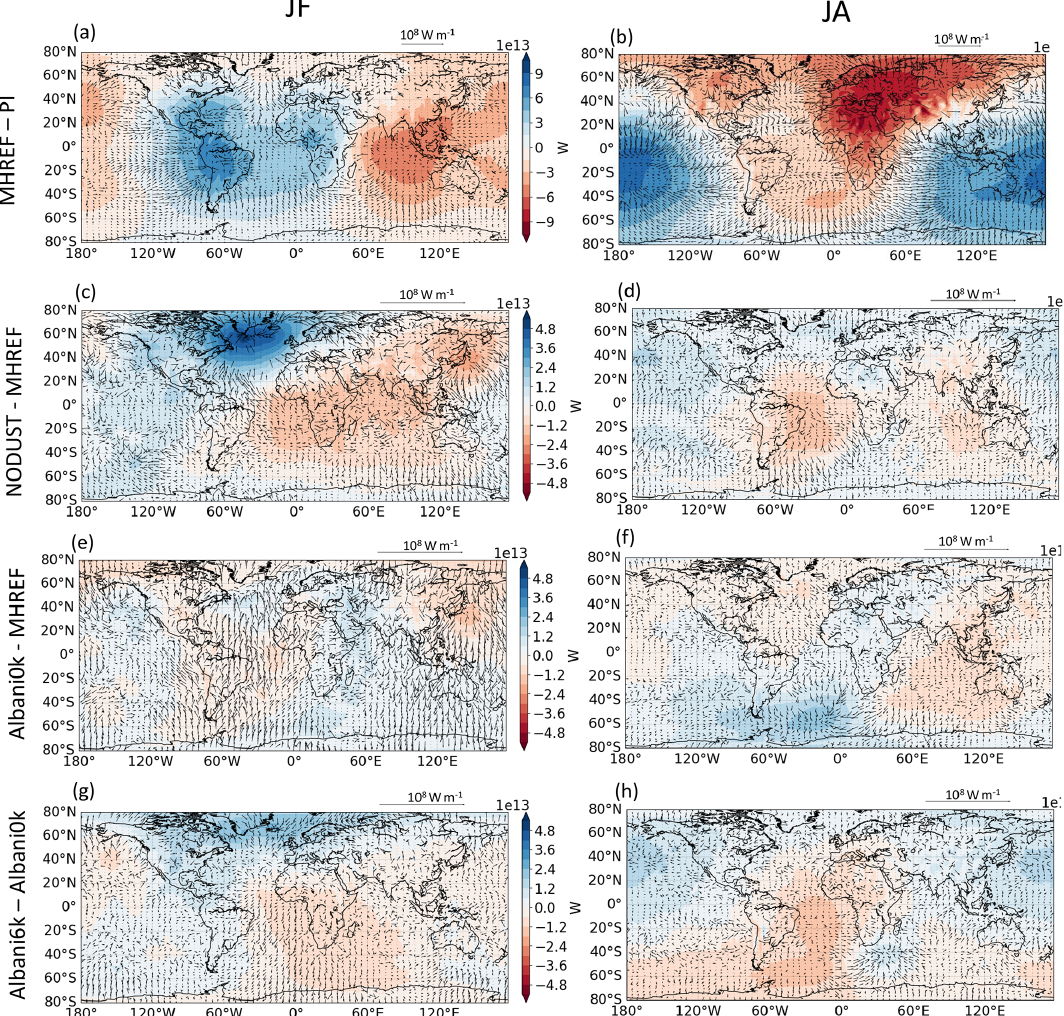
Figure 9. Difference of moist static energy integrated over the atmospheric column (W) and associated moist static energy transport (Wm − 1 ) between (a) the January–February (JF) and (b) July–August (JA) averaged mid-Holocene reference and pre-industrial control simulations (MHREF–PI) , (c) the JF and (d) JA averaged mid-Holocene NODUST) and MHREF simulations (NODUST–MHREF), (e) the JF and (f) JA averaged mid-Holocene Alabani0k and MHREF simulations (Albani0o–MHREF), and (g) the JF and (h) JA averaged mid-Holocene Albani6k mid-Holocene Albani0k simulations (Albani6k–Albani0k). To better highlight the differences induced by the different dust fields a factor of about 2 has been applied to the legend and reference length of the arrow between the first row and the others